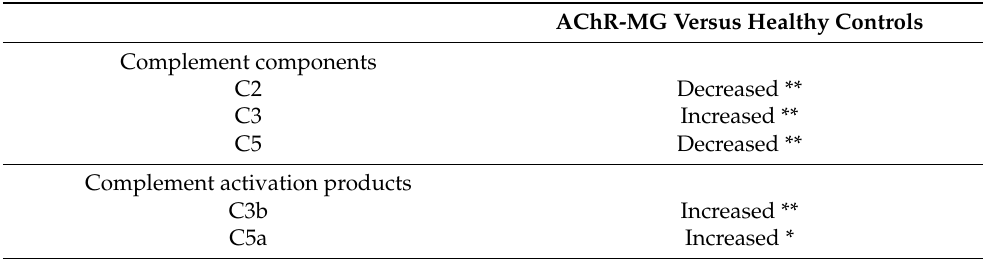
Table 2. Complement Activation Profile in Plasma of AChR-MG